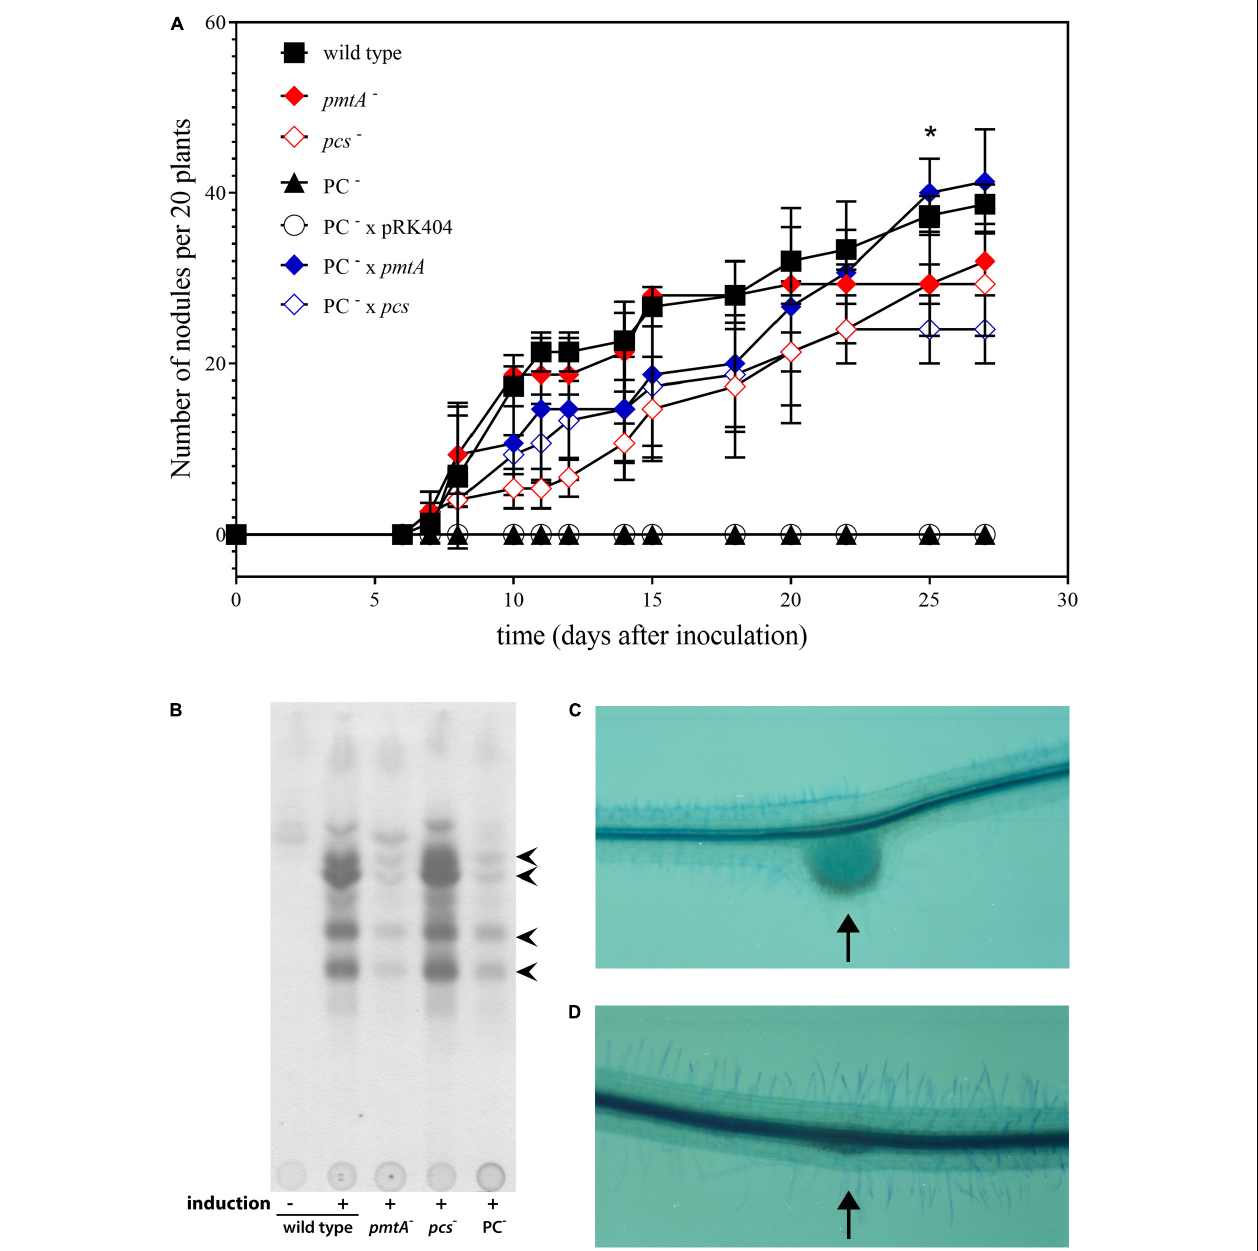
FIGURE 2 | Symbiotic performance of Sinorhizbium meliloti strains affected in PC biosynthesis. (A) Nodulation kinetics of S. meliloti wild type and mutant strains on alfalfa plants. Results for S. meliloti wild type strain 1021 ( (cid:110) ), pmtA -deficient mutant KDR516 ( ), pcs -deficient mutant KDR568 ( ), PC-deficient mutant OG10017 ( (cid:115) ),PC-deficient mutant OG10017 harboring the empty plasmid pRK404 ( (cid:13) ),PC-deficient mutant OG10017 complemented with pmtA -expressing plasmid pTB2042 ( ), and PC-deficient mutant OG10017 complemented with pcs -expressing plasmid pTB2532 ( ). The symbols of (cid:115) and (cid:13) overlap. Values represent means of three independent experiments and standard deviation is shown. Statistical analysis was performed by a two-way ANOVA with Tukey’s multiple comparisons test as described in Materials and Methods. As an example, comparisons at 25 d after inoculation reveal that nodule numbers of all PC-deficient strains (PC - , PC - x pRK404) are significantly different (* p < 0.05) from PC-containing strains (wild type, pmtA - , pcs - , PC - x pmtA ), except pcs - versus PC - or pcs - versus PC - x pRK404 ( p < 0.0557). (B) PC-deficient S. meliloti mutant can form nodulation (Nod) factors. Thin-layer chromatographic analysis of Nod factor formation when S. meliloti wild type 1021 was not induced (lane 1) or induced with the flavonoid naringenin (lane 2), or when pmtA -deficient mutant KDR516 (lane 3), pcs -deficient mutant KDR568 (lane 4), or PC-deficient mutant OG10017 (lane 5) were induced with naringenin. All strains carried plasmid pMP280 for an increased production of Nod factors (Spaink et al., 1987). Arrowheads mark different Nod factors formed by S. meliloti . (C,D) PC-deficient S. meliloti mutant triggers initiation of nodule meristems on alfalfa roots. Arrows indicate a nodule induced by S. meliloti wild type (C), or a typical nodule meristem induced by the PC-deficient mutant OG10017 (D), respectively, 10 d after inoculation. For (C) and (D) , roots were cleared with hypochlorite and stained with methylene blue as described by Truchet and collaborators (Truchet et al., 1989).